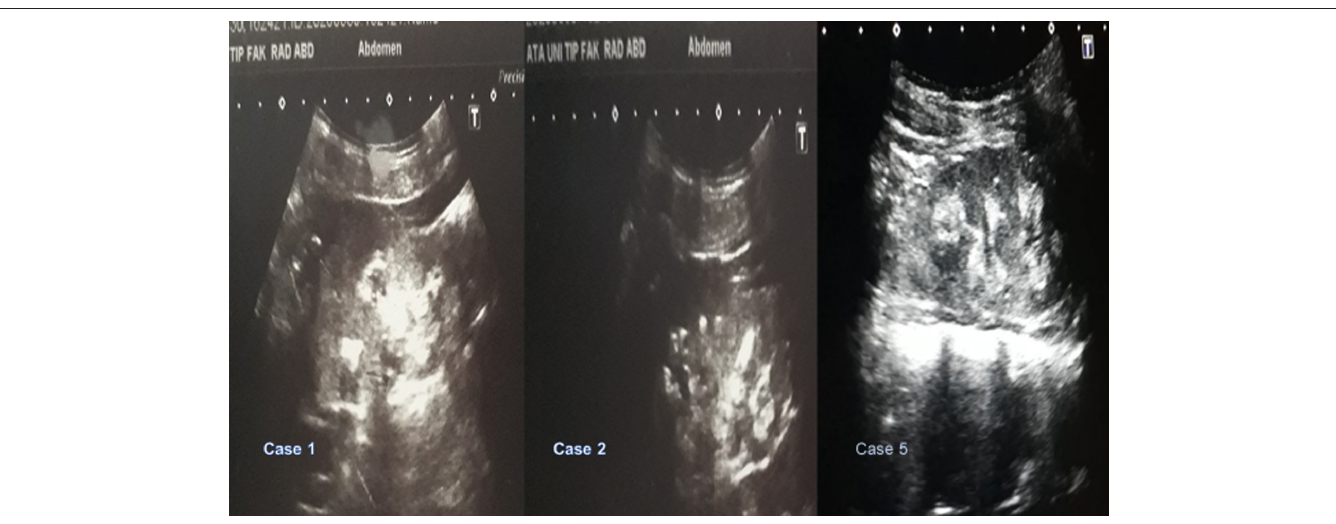
Figure 2. Bilaterally medullary nephrocalcinosis in kidney ultrasonography in cases 1, 2, and 5, showing an increase in bilateral parenchymal echoes and an intense increase in echogenicity in bilateral medullary pyramidal structures (grade 3 medullary